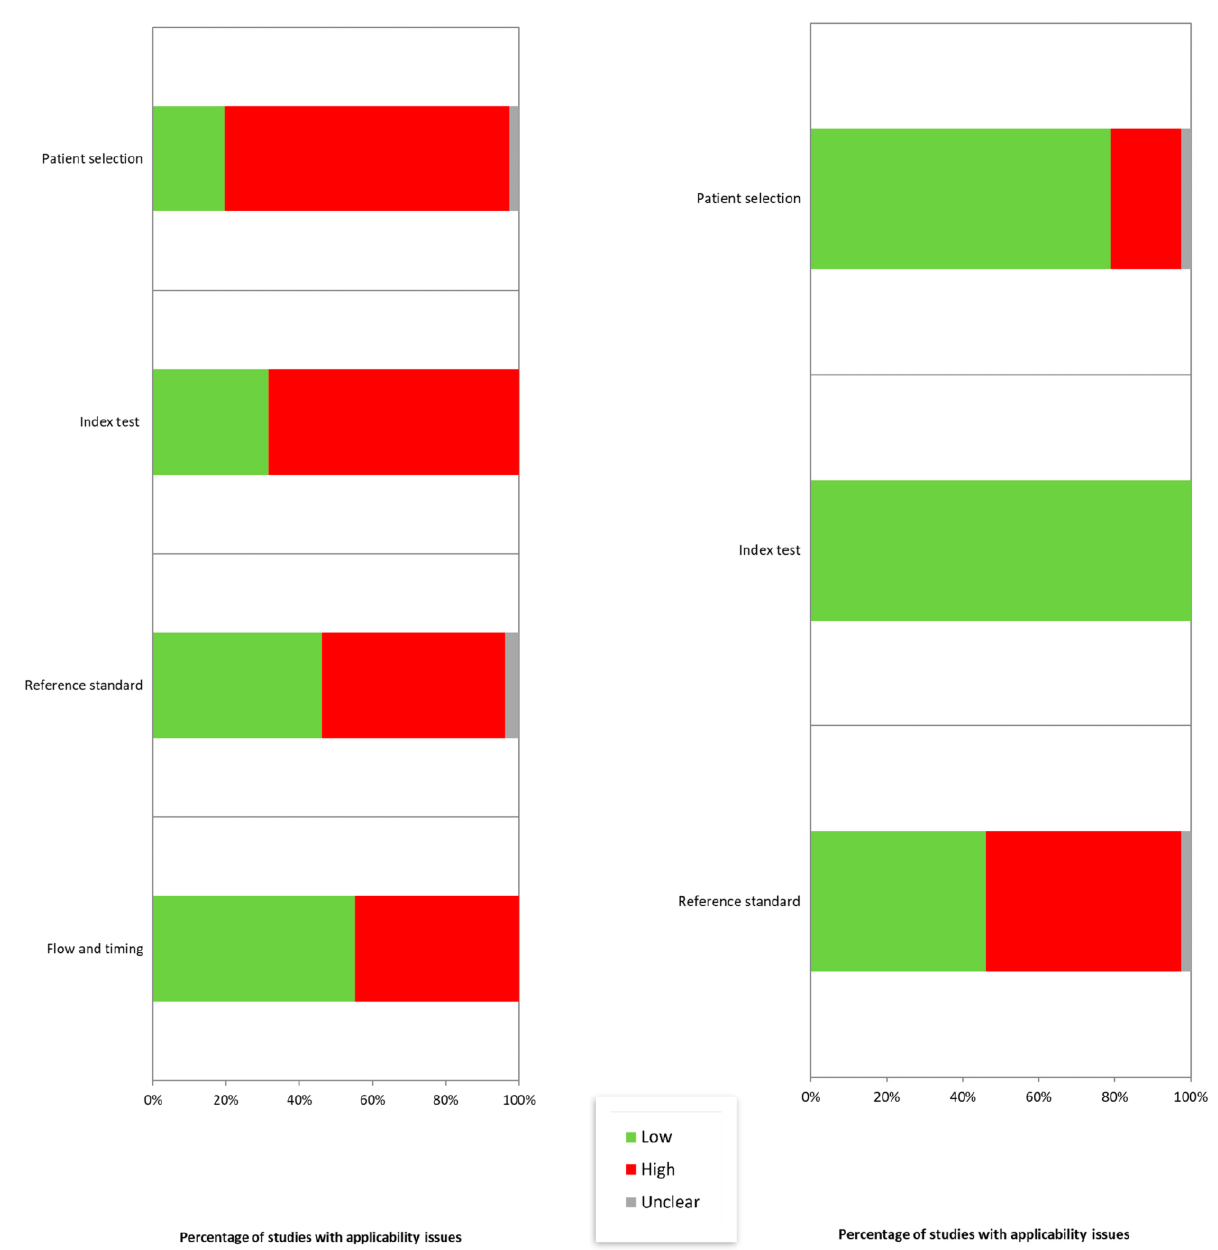
Figure 6. Evaluation of publication bias of all reported microRNAs presented as funnel plots.